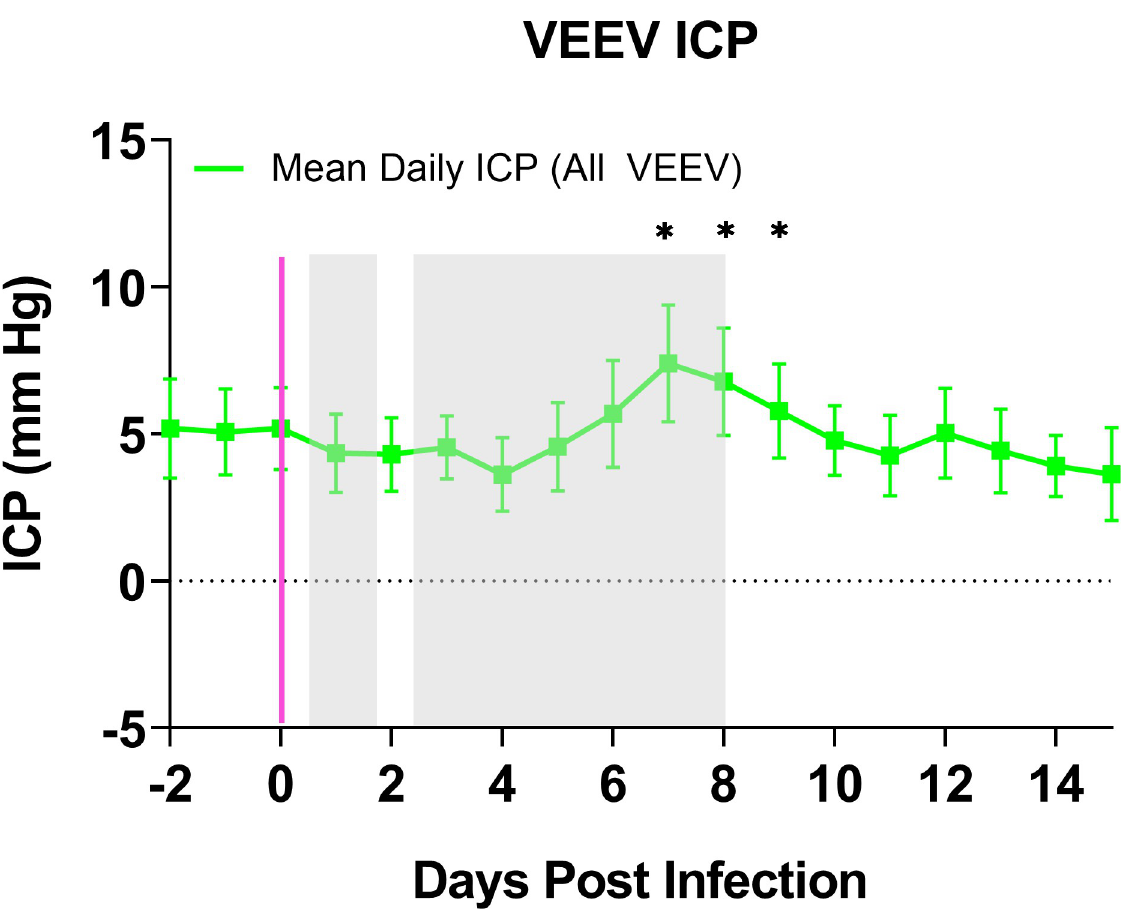
Fig 6. Intracranial Pressure in VEEV-infected NHPs. Mean ICP (daily mean +/- SEM) in VEEV-infected macaques (n = 6) superimposed upon gray boxes indicating febrile period. Magenta line indicates aerosol challenge. Two-factor repeated measures ANOVA with post-hoc pairwise comparisons found a significant increase in ICP compared to mock-infected macaques on days 7–9 post infection, denoted by the asterisk-topped